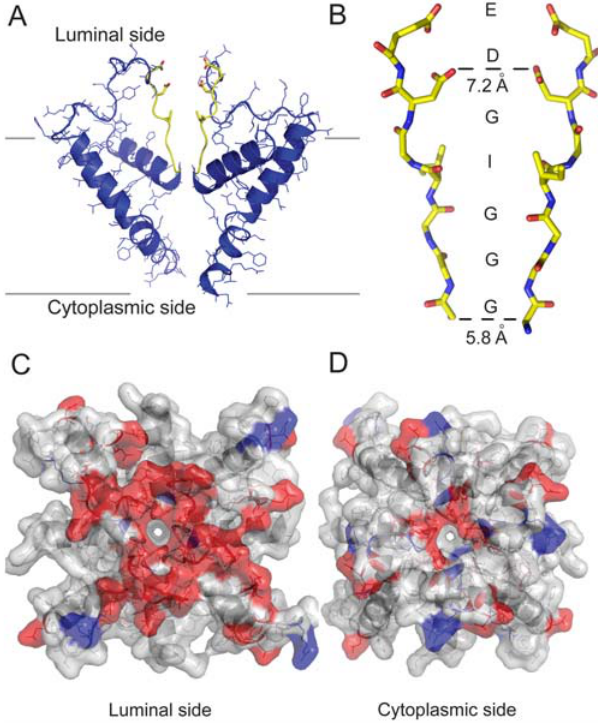
Figure 1. The pore model. (A) Two opposing RyR1 monomers shown in cartoon representation. The selectivity filter (the motif 4894GGGIGDE) is shown in yellow. (B) Selectivity filter region of two opposing RyR1 monomers shown in stick representation. The sequence of the fragment is shown along the path of the ions. The molecular surface of the luminal face (C) and the cytoplasmic face (D) of RyR1 pore tetramer. Negative residues are shown in red while positive residues are shown in blue and the neutral residues are shown in white. This figure was created using PyMOL (http://pymol.sourceforge.net/).